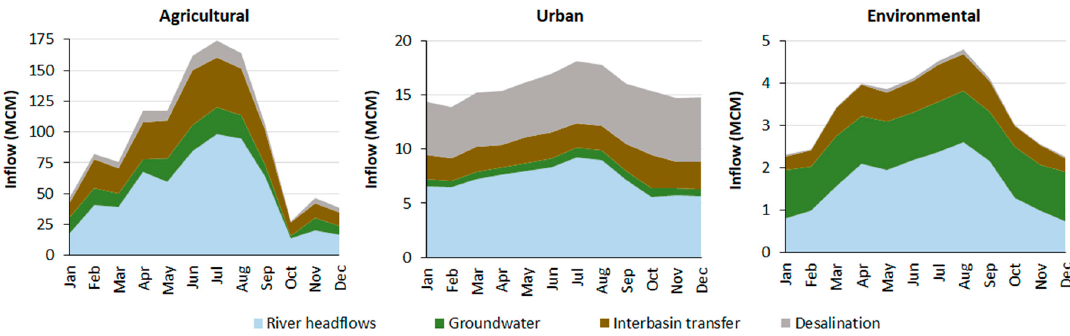
Figure 4. Original sources of water for different types of water use in the Segura River Basin. Percentages indicate the overall contribution of the respective source to annual average supply.